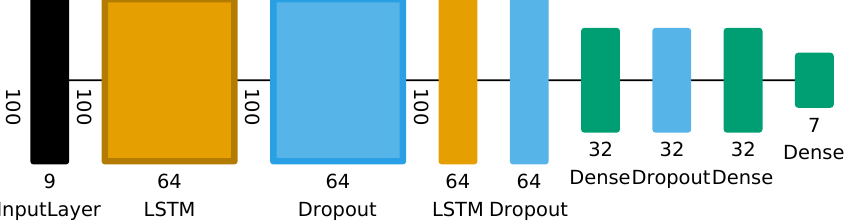
Figure 4. Schematic of the used neural network model. Hyperparameter optimization was used for the LSTM layer size (16/32/64) and Dropout (0.2–0.8). The size of the final dense layer varies depending on the number of classes needed for each classifier